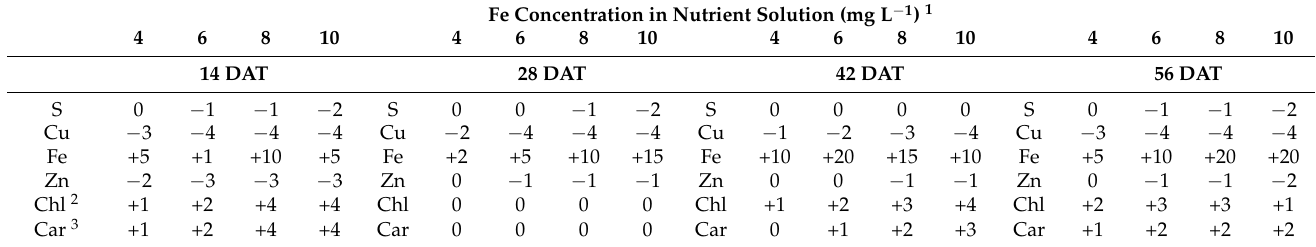
Figure 5. Ascorbic acid content in collard greens as a function of iron concentration in the nutrient solution at 14, 28, 42 and 56 days after the application of treatments (DAT). Significant at ** p ≤ 0.01. Table 1. Collard green leaf quality as a function of the iron concentration in the nutrient solution on leaf nutrient, pigment and ascorbic acid contents at 14, 28, 42 and 56 days after the application of treatments